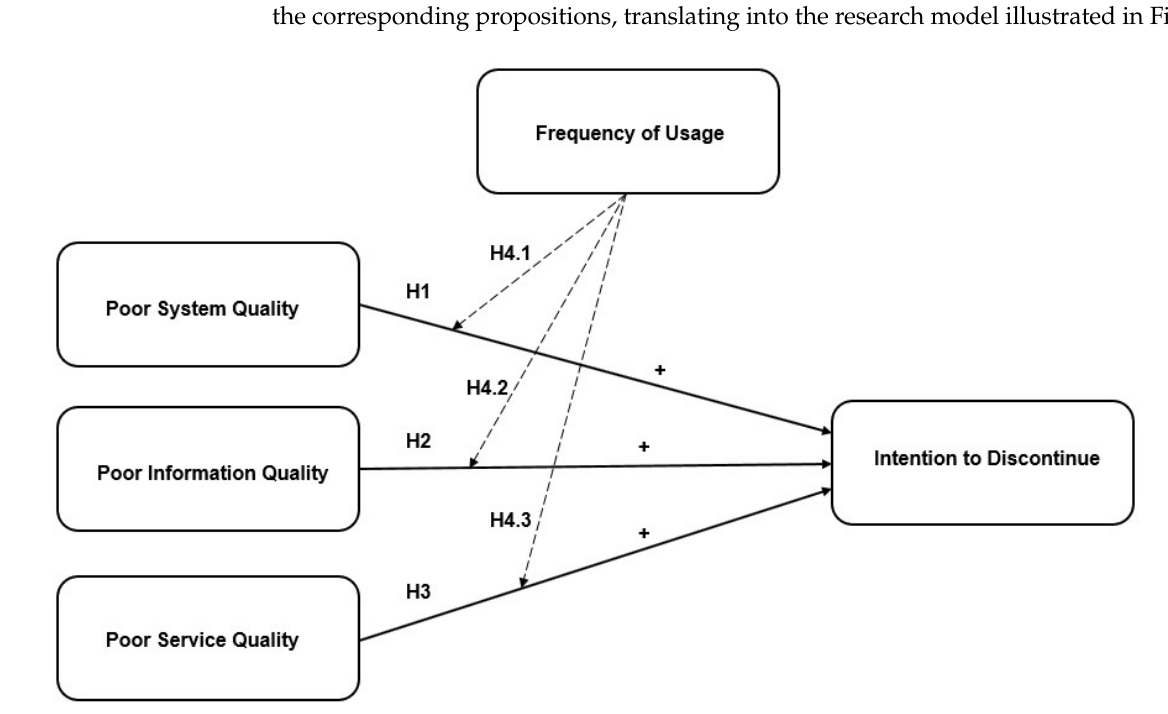
Figure 1. The research model.